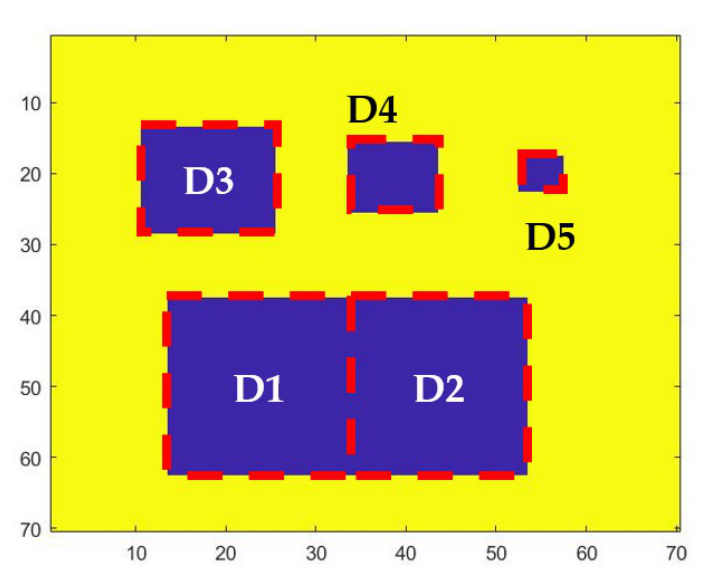
Figure 8. Ground truth labeling of accurate measurement, where D1, D2, D3, D4 and D5 denotes as Defect 1, Defect 2, Defect 3, Defect 4, and Defect 5, correspondingly.